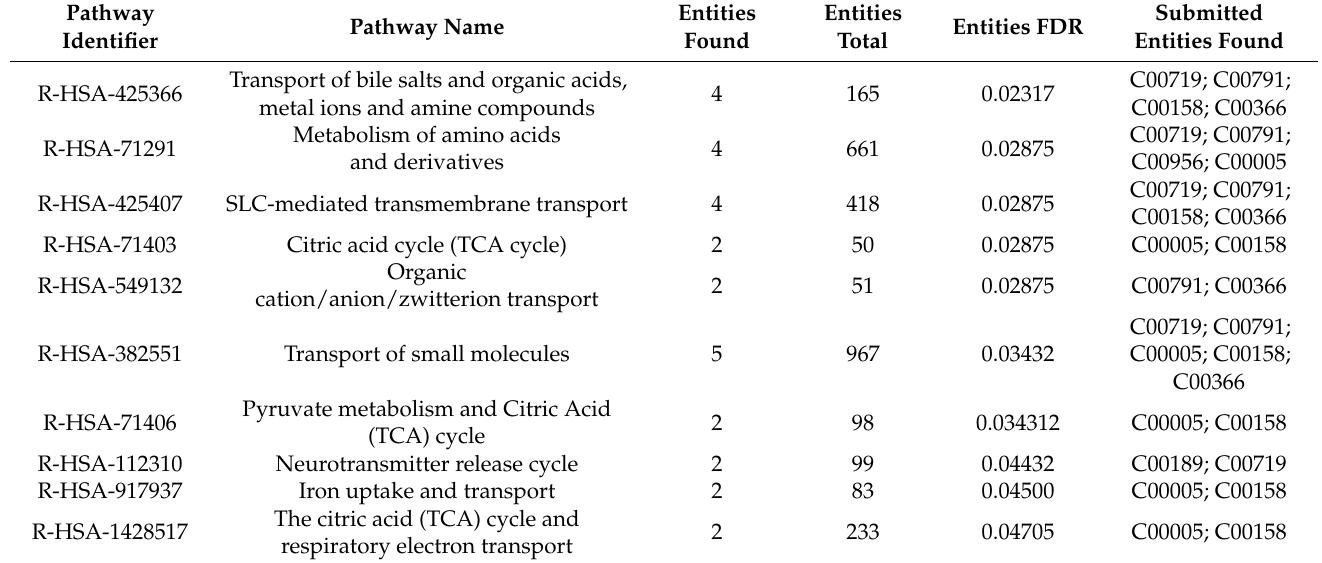
Table 1. Biological pathways showing overrepresentation with metabolites from a 16-metabolite set with highest correlation between plasma and CSF samples.